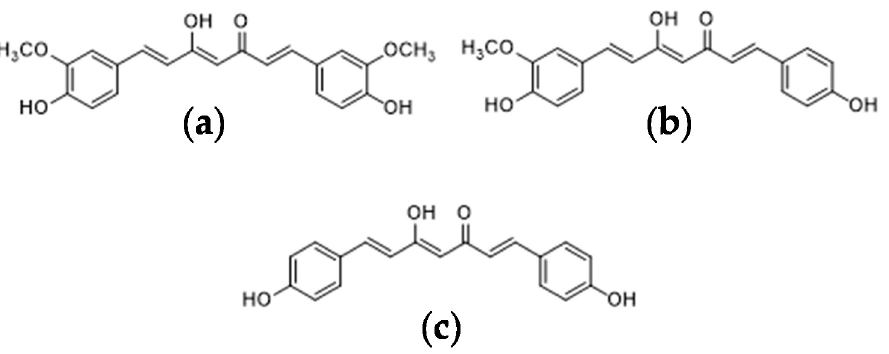
Figure 1. Chemical structures of curcuminoids: ( a ) curcumin (CUR), ( b ) demethoxycurcumin (DMC), ( c ) bisdemethoxycurcumin (BDMC).